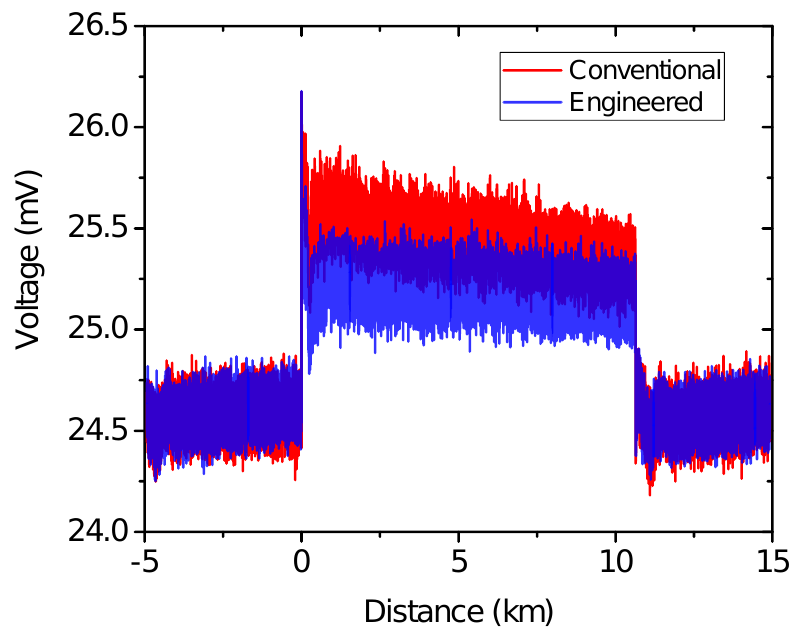
Figure 13. Time domain traces measured with the conventional (red) and engineered (blue) BGS at a pump-probe frequency offset of 10.605 GHz for static sensing. The voltage level of the trace with the engineered BGS is down shifted for a better